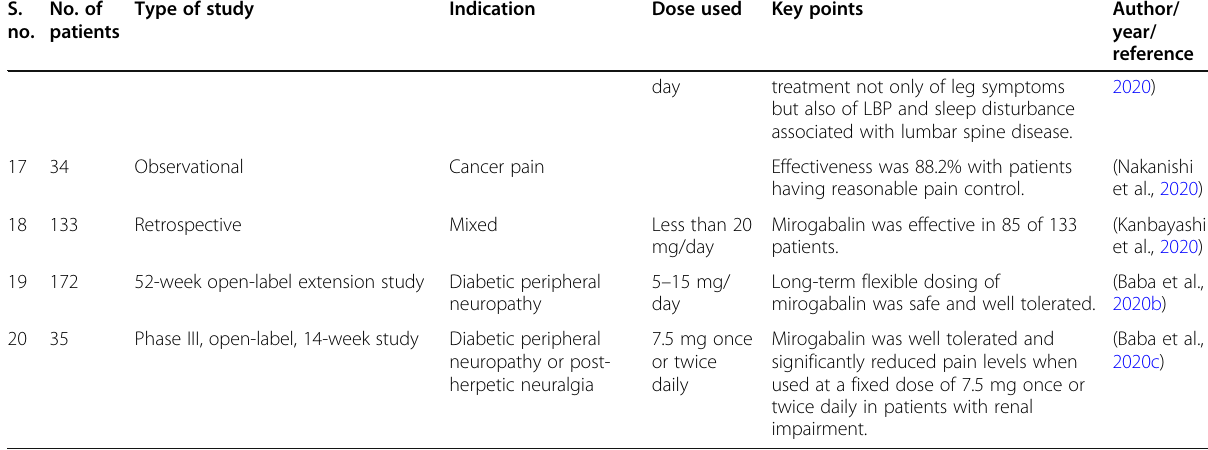
Table 1 Table showing studies in which mirogabalin was used in various chronic pain conditions (Continued) S. No. of Type of no. patients